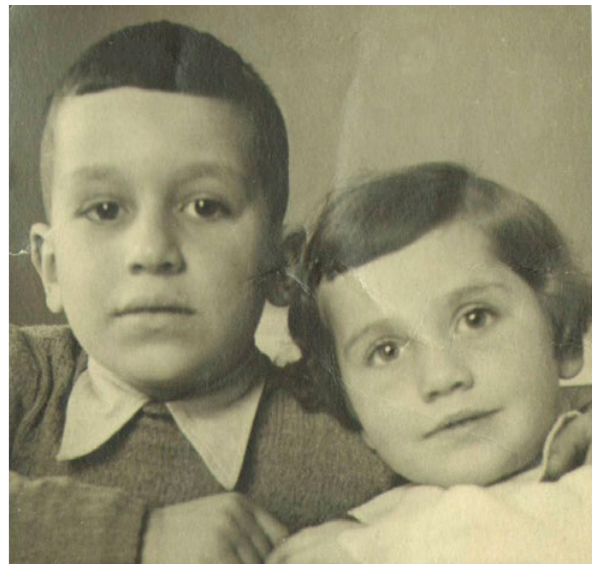
Figure 4. Giosuè and Irene in Italy (1938); (from the private collec- tion of the Jolles-Bainbridge family, now in the Fondo Jolles at Flor- ence University Museum of Natural